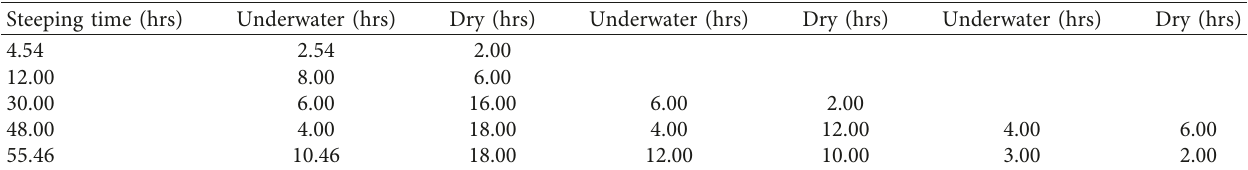
Table 2: Steeping time with variations in wet and dry